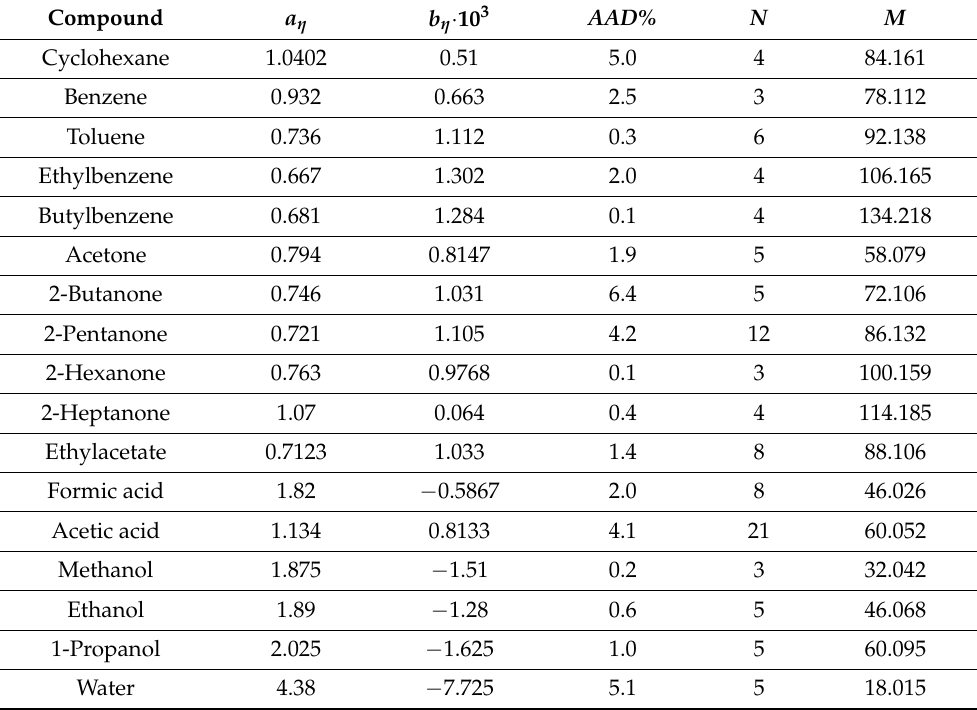
Table 6. The a η and b η values for the compounds with relative molecular masses M and the AAD% from a comparison of the calculated viscosity coefficients to the literature data [10] for N measure- ments in the temperature range of − 25 < t < 100 ◦